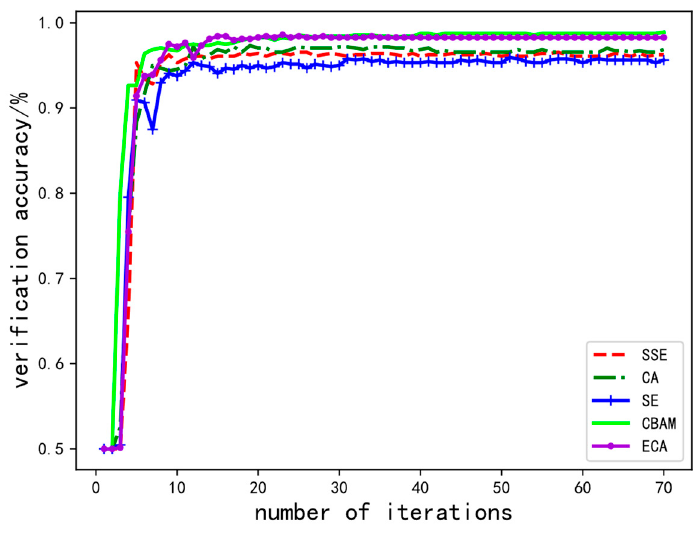
Figure 12. Verification accuracy of attention module comparison experiment.